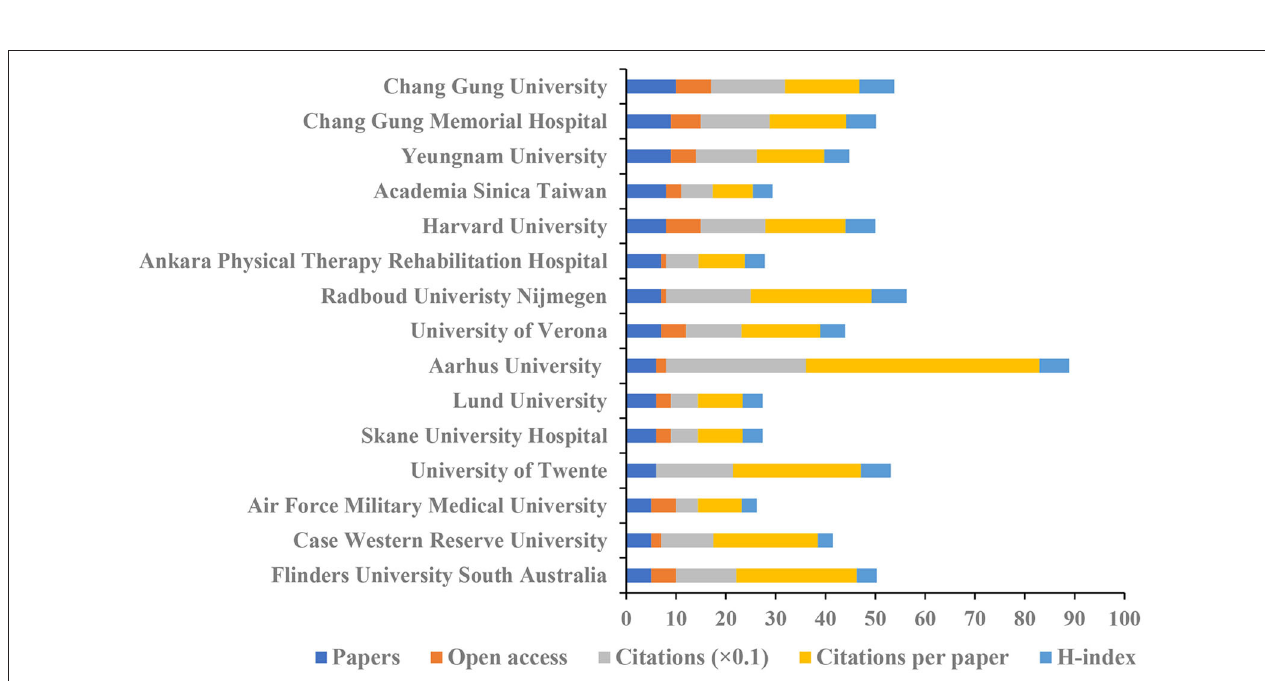
FIGURE 8 | The number of articles, citations, citations per articles, and open-access articles, and H-index of the top 15 institutions.